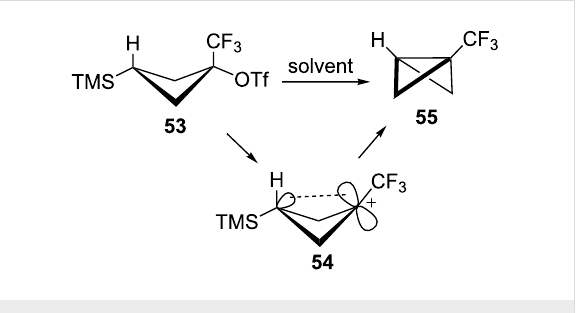
Scheme 12. Reduction of the ester mixture 57 with lithium alu-